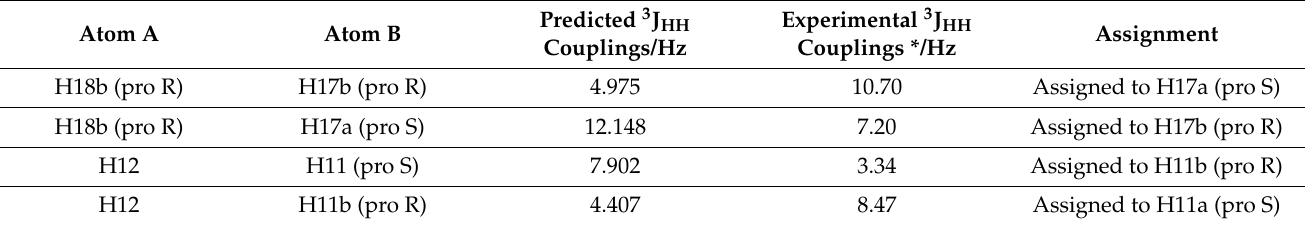
Table 1. MDOC prediction of selected 3 J HH couplings in comparison to the experiment. The error of the predicted values is estimated to be 1.25 Hz as the sum of the experimental error plus the uncertainty of the Altona